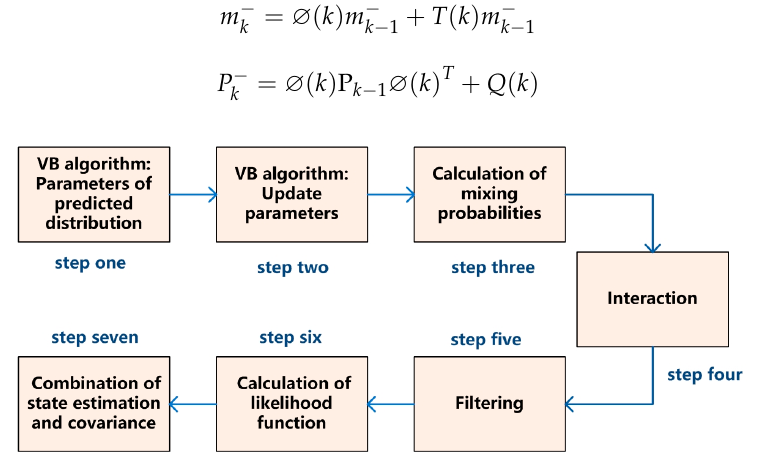
Figure 4. The formal algorithm flow.